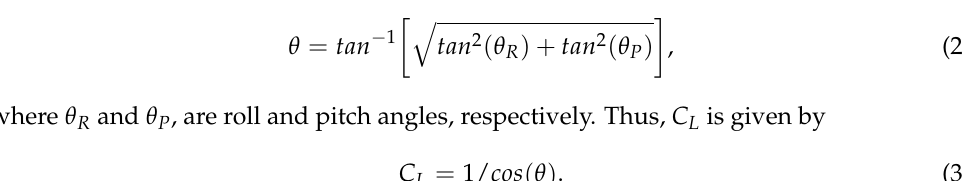
Figure 6. MGD records obtained using IPDA lidar support instruments during airborne operation onboard NASA B-200 aircraft on 17 September 2019. The records include ( a ) GPS and INS altitude measurement and line-of-sight calculations, ( b ) DEM ground elevation, ( c ) temperature and ( d ) pressure from the meteorological sensor, and ( e ) water vapor and ( f ) carbon dioxide dry-air mixing ratios from the PICARRO in situ sampler. All records are presented versus local time, derived using GPS UTC